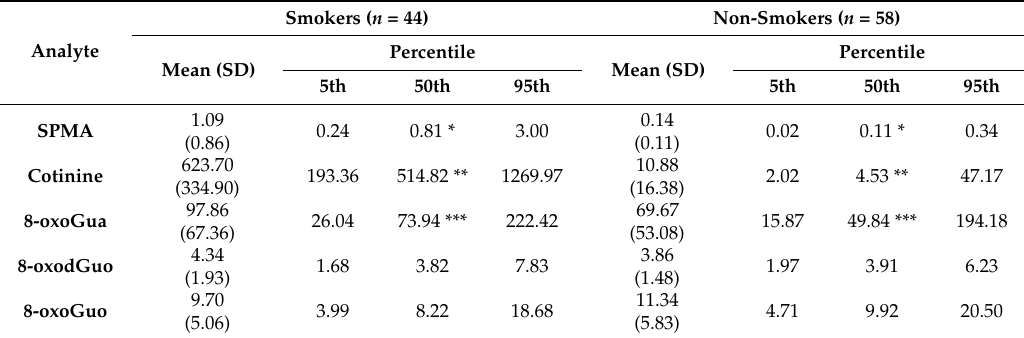
Table 4. Concentrations ( µ g/g creatinine) of metabolites for chemical exposure (SPMA and cotinine) and oxidation biomarkers (8-oxoGua, 8-oxodGuo and 8-oxoGuo) in Group 2, after shift, stratified by smoking